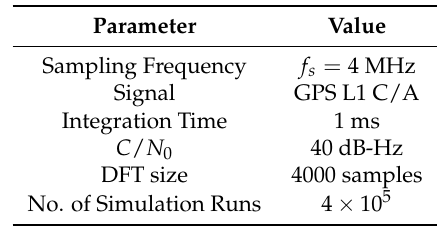
Table 1. Simulation parameters used for the evaluation of the loss, L 0 ( T h ) , for the case of frequency domain processing.